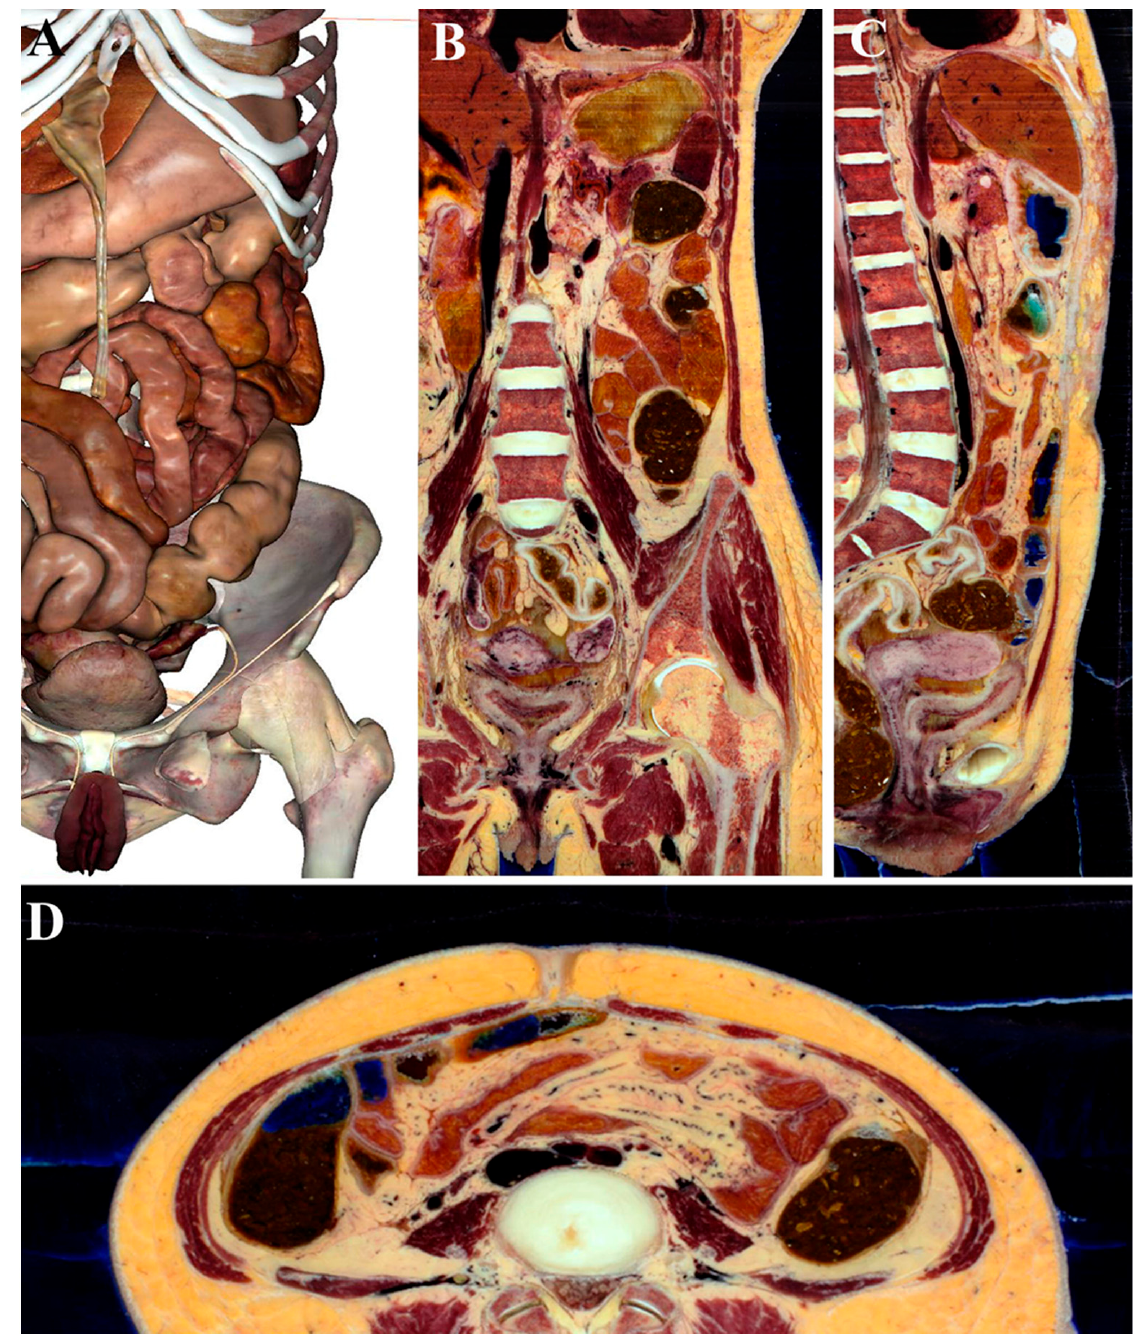
Figure 1. Abdominal region ( A ) of Asian adult male observed in the coronal ( B ), sagittal ( C ), and axial projection plane ( D